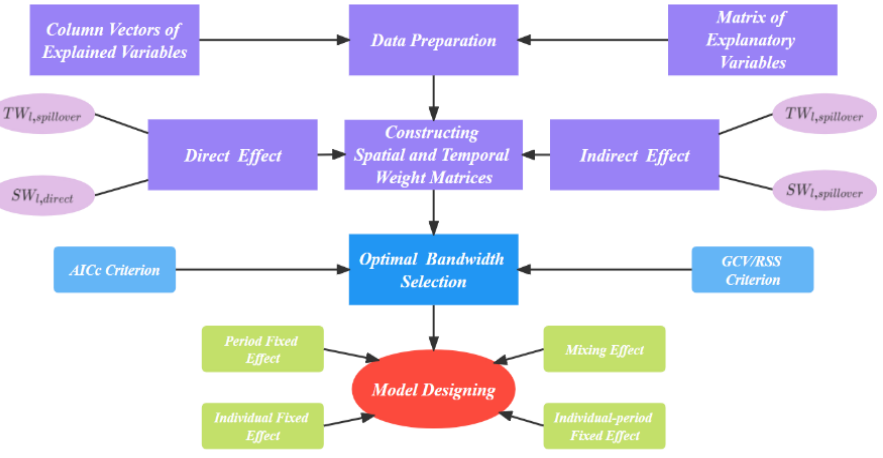
Figure 1. An overview of the PGTWR model.